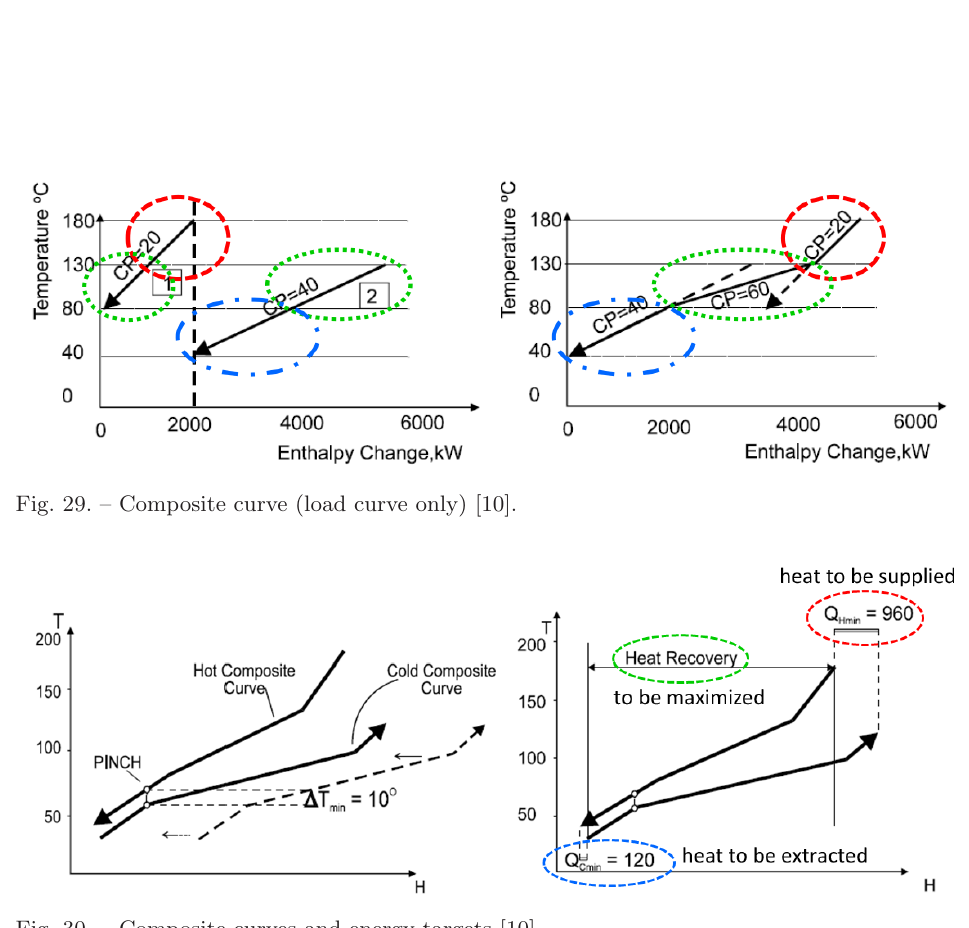
Fig. 30. – Composite curves and energy targets